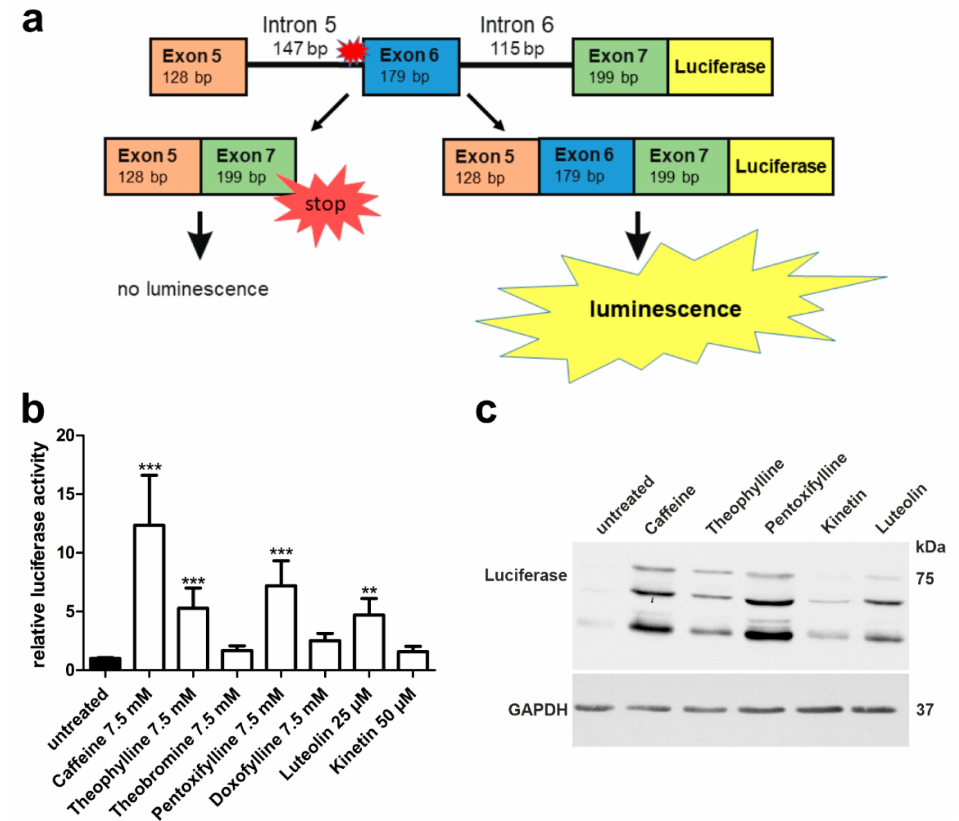
Figure 11. TPP1 minigene luciferase splicing assay in HEK293T cells: Effect of methylxanthines, luteolin, and kinetin. ( a ) Schematic drawing of the TPP1 minigene construct containing the variant c.509-1G<C, with C-terminal firefly luciferase. ( b ) HEK293T cells were transfected with the TPP1 luciferase minigene construct containing the variant c.509-1G<C and treated with the indicated sub- stances for 24 h. Relative luciferase activity of the untreated samples was set as 1. Bars represent the mean ± SD of at least five independent experiments, one-way ANOVA against the untreated samples. Values of p < 0.01 were considered very significant (**) and p < 0.001 extremely significant (***). ( c ) Protein lysates from ( b ) were analyzed by SDS-PAGE and Western blot with an anti-luciferase antibody. Luciferase expression was observed in the samples showing significant luciferase activity in ( b